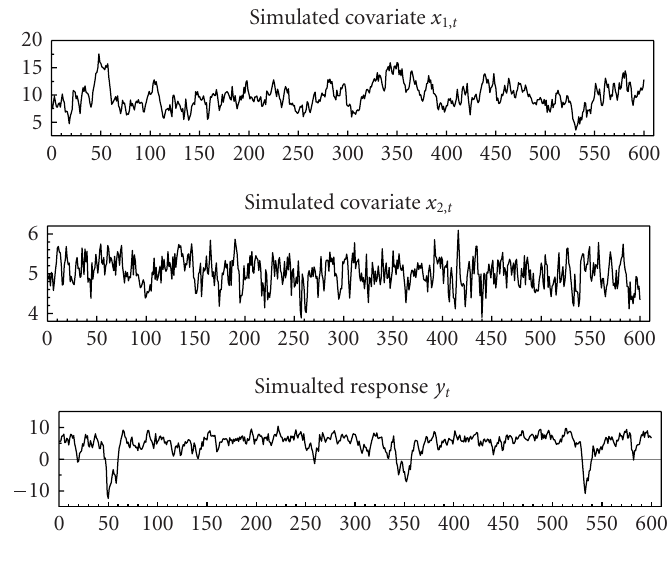
Figure 6.2. Simulated time series for both covariates the x 1, t and x 2, t and the response y t .